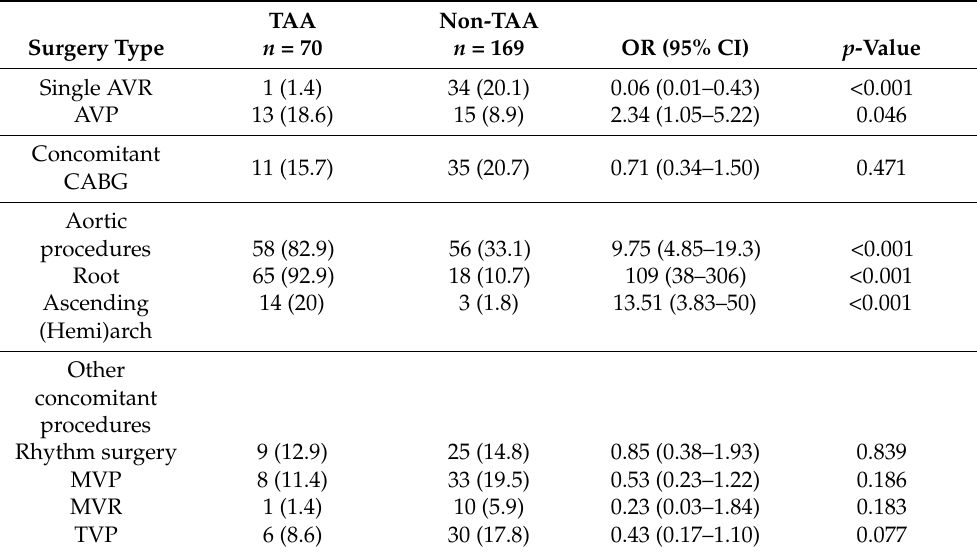
Table 2. Perioperative